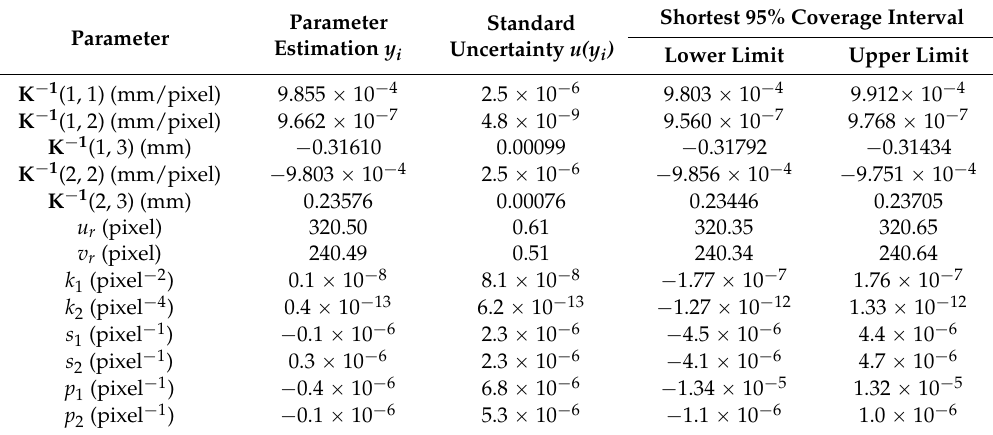
Table 1. Results of the calibration parameters of the optical coordinate measuring